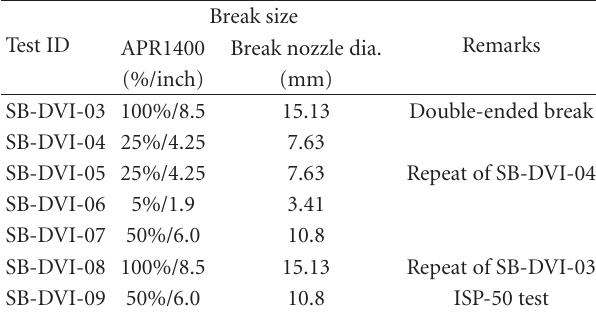
Table 3: Test matrix for the DVI line SBLOCA